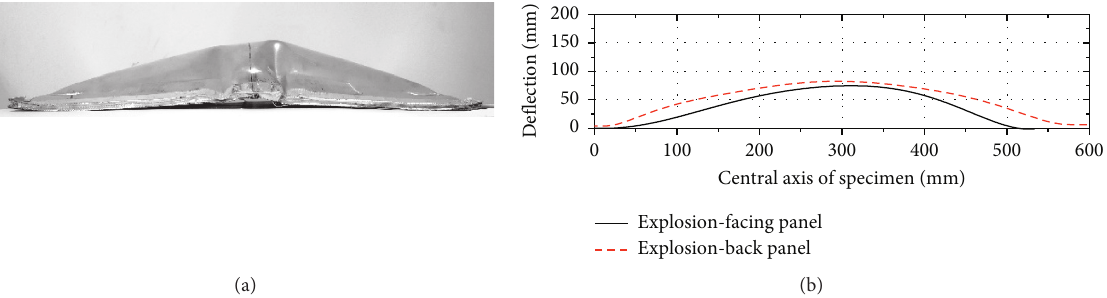
Figure 12: Side deformation and deflection of ST1. (a) Side view of ST1 deformation. (b) ST1 deflection data curve.